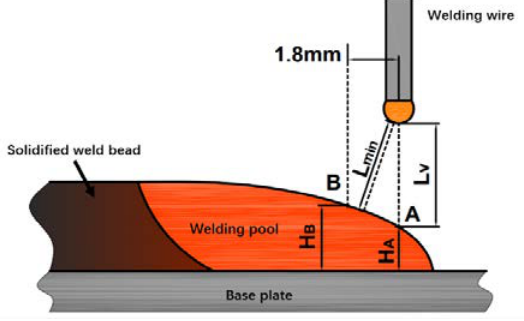
Figure 1. Experimental system and image processing system.